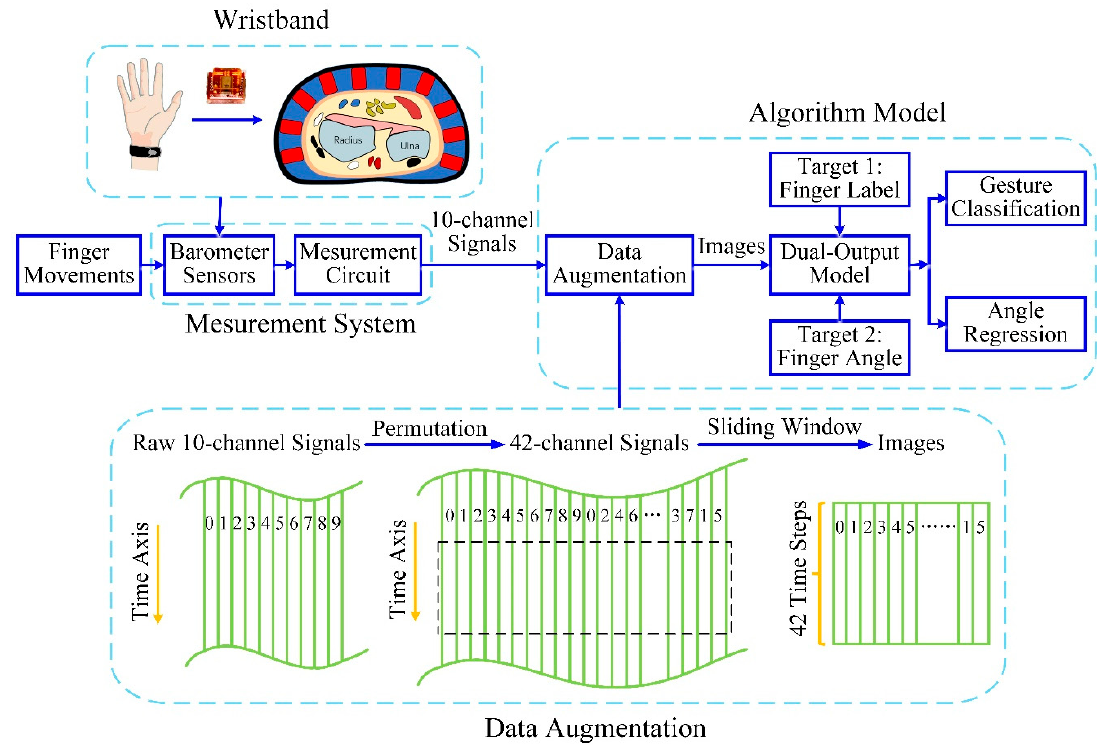
Figure 1. System framework of the novel dual-output convolutional neural network (CNN) model for simultaneous hand gesture recognition and finger angle estimation.